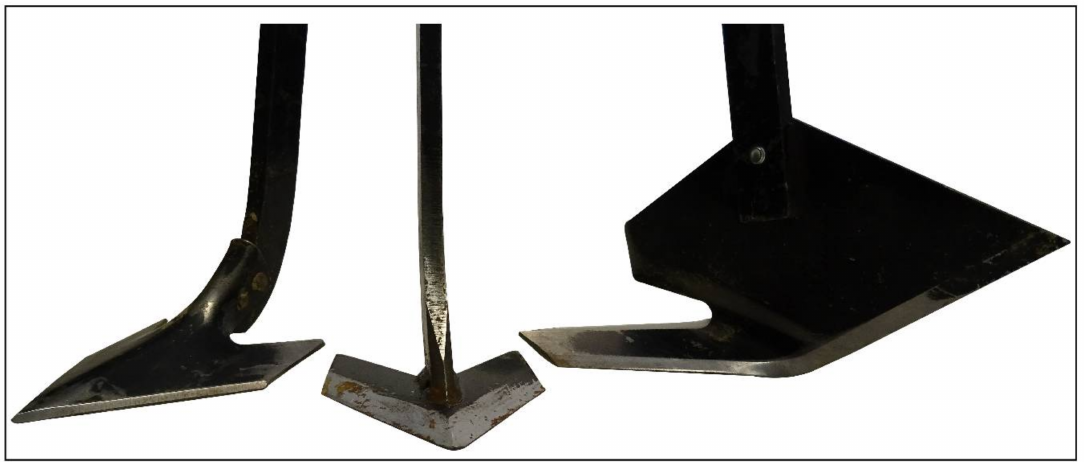
Figure 2. Group image of the three cultivation sweeps used in this study. From left to right: goosefoot sweep, no-till sweep and down-cut side knife. The depicted sweeps were adjusted to a row spacing of 150